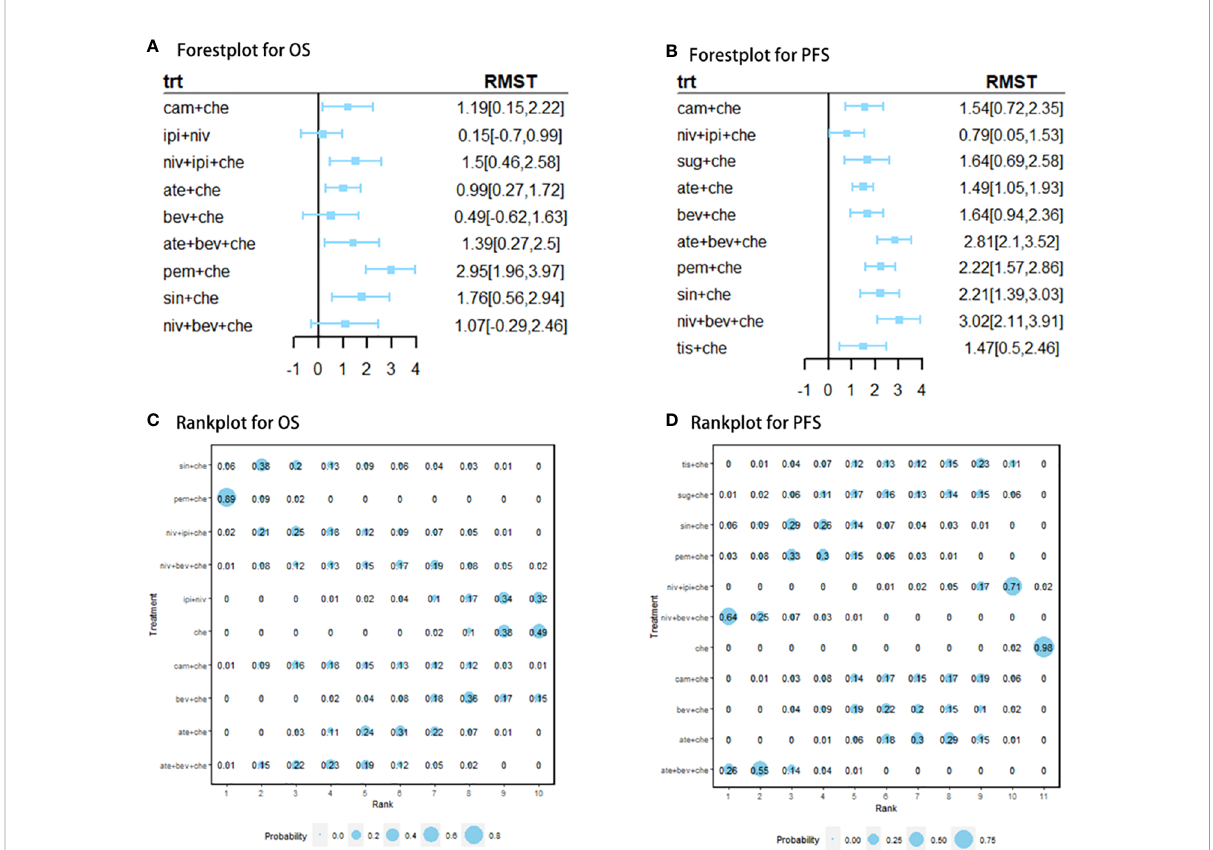
FIGURE 3 (A) forest plot of RMST for OS; (B) forest plot of RMST for PFS; (C) rank plot for OS; (D) rank plot for PFS. Forest plot of restricted mean survival time (RMST) and rank plot for overall survival (OS) and progression-free survival (PFS). In the rank plot, the size of each point is proportional to the probability (i.e., the probability of being the best treatment in terms of survival bene fi ts at 12 or 18